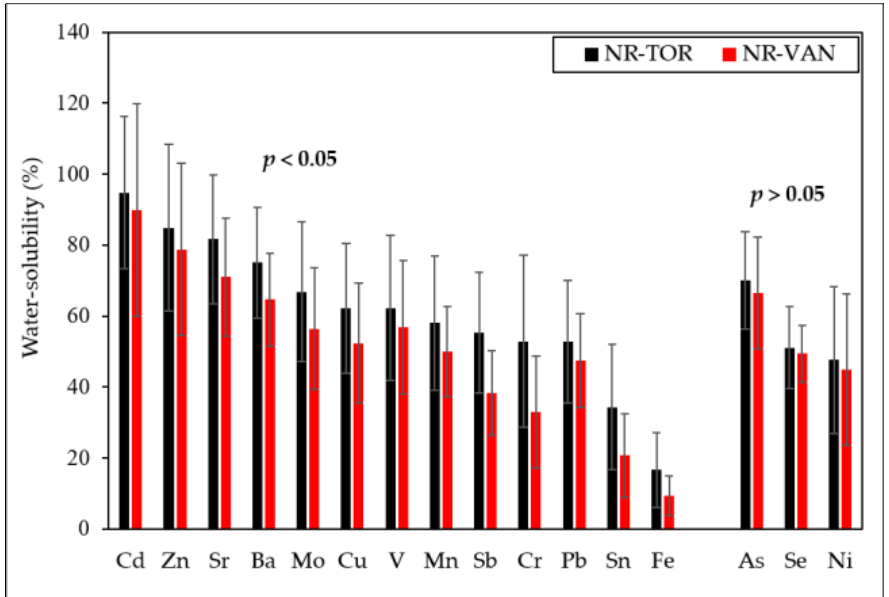
Figure 4. Mean water-solubility (%) of specific PM 2.5 -bound elements at near-road sites. Error bars represent standard deviation. Kolmogorov-Smirnov test with 95% probability was used to compare solubility of elements at two near-road sites.